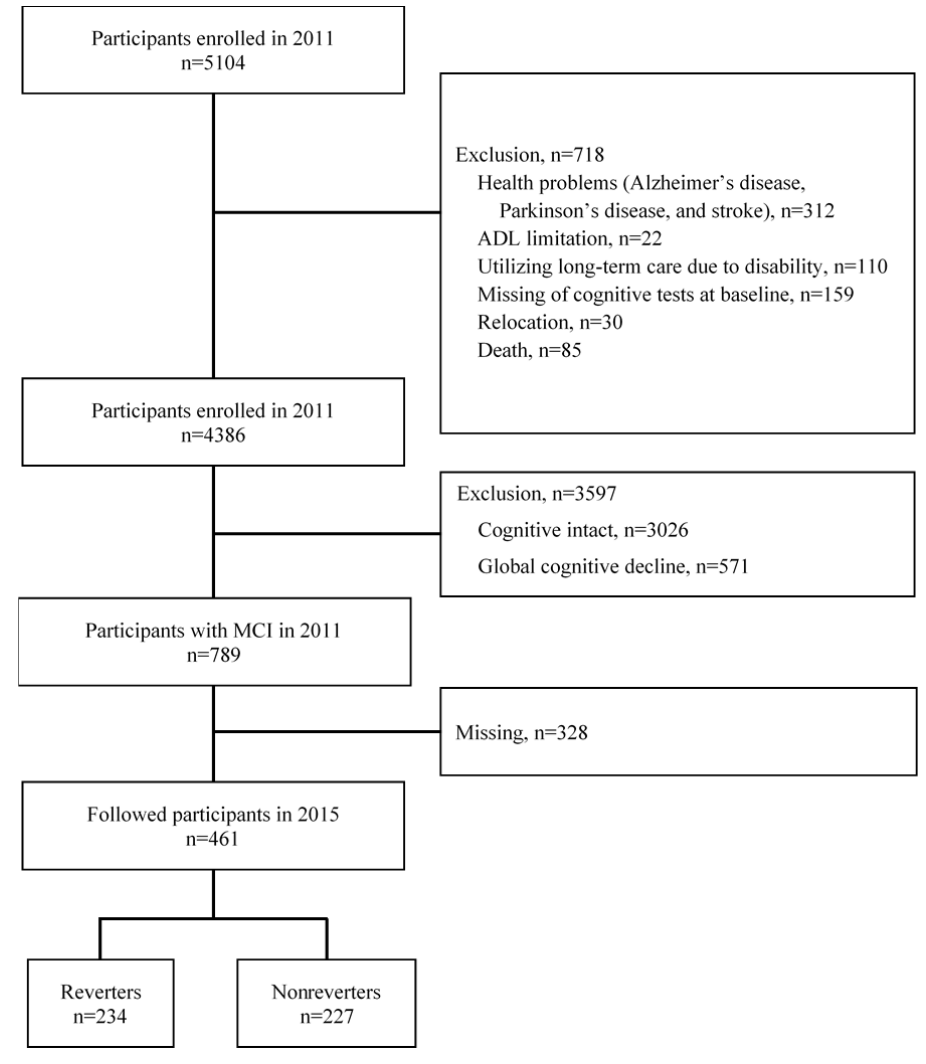
Figure 1. Flow diagram of sample selection.